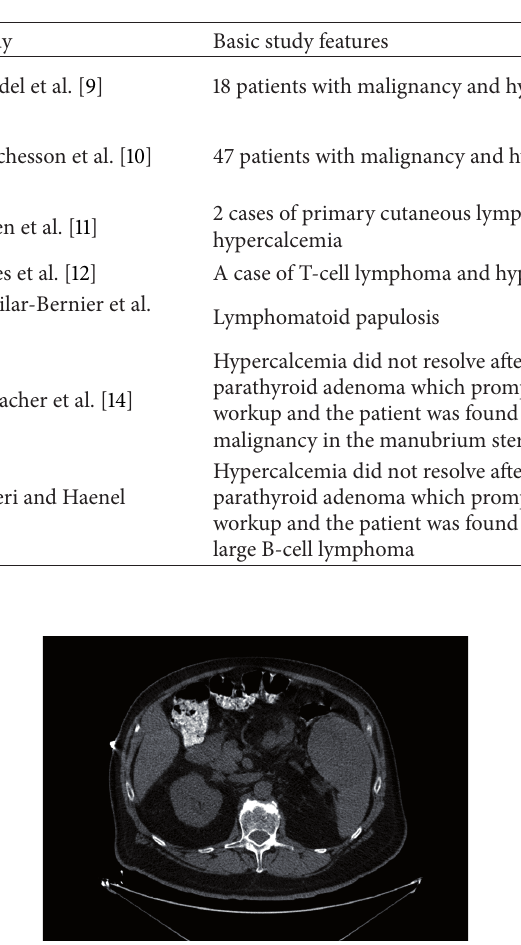
Table 2: The literature review of reported cases of hypercalcemia and malignancy.